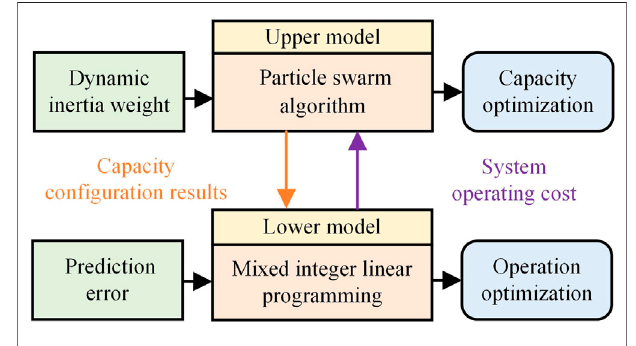
FIGURE 2 | Structure of the robust bi-level planning